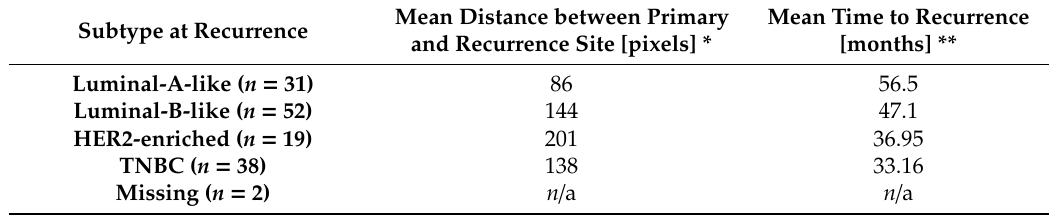
Table 4. Recurrence characteristics with regard to subtype at